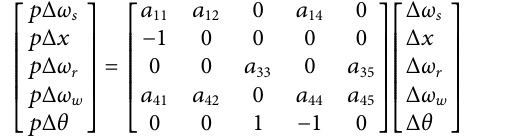
TABLE 2 | The parameters of synchronous generators.